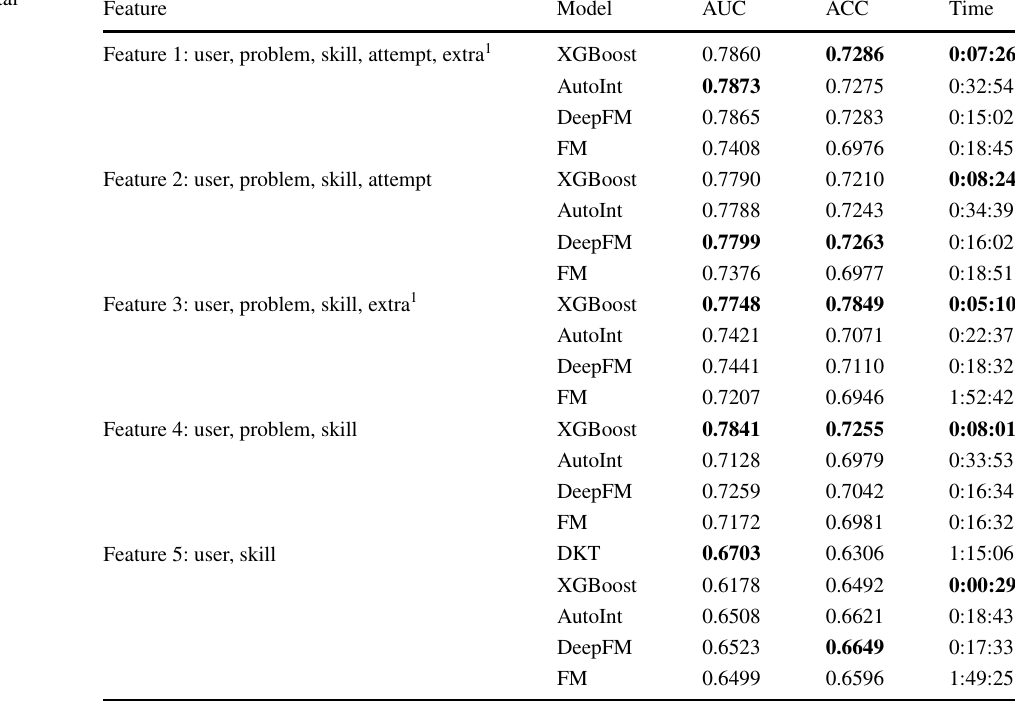
Bold fonts indicate the best results of the